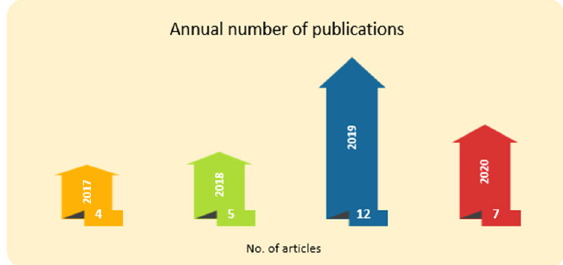
Figure 2. Annual number of publications.